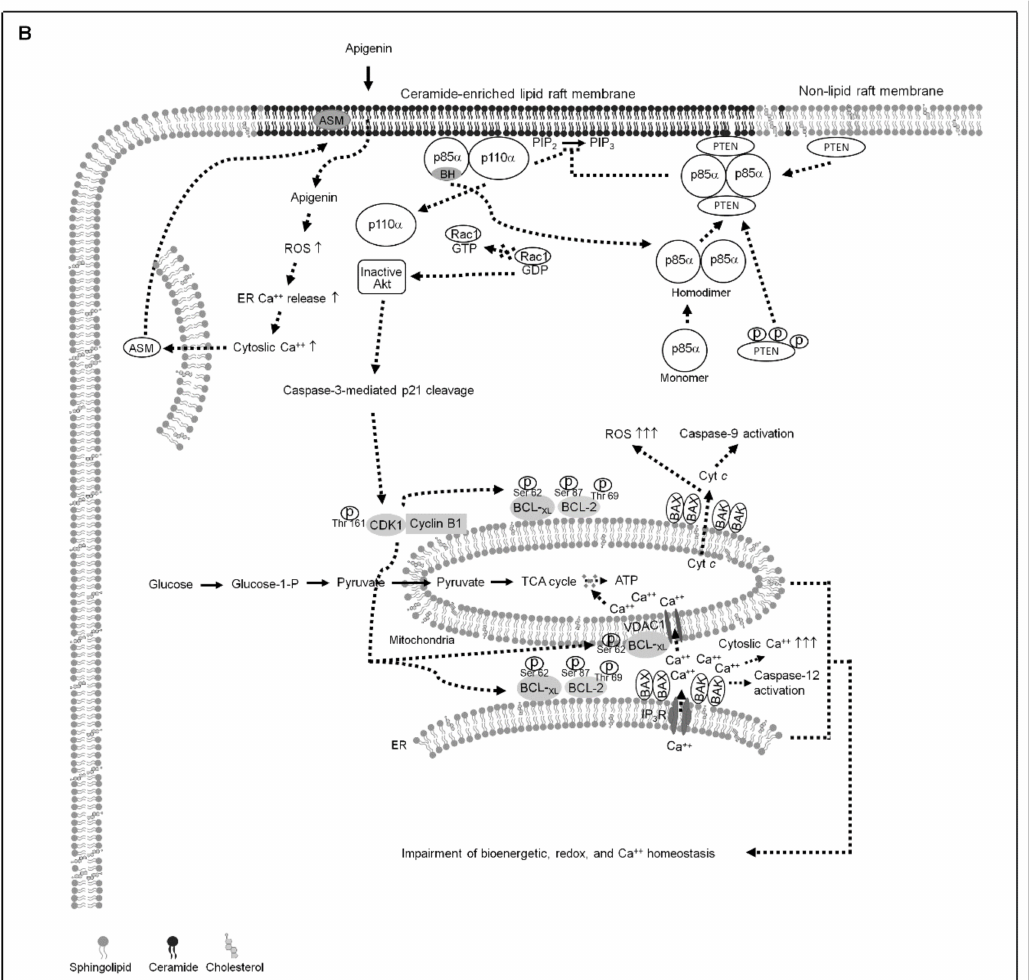
Figure 7. A molecular model for the attenuation of endoplasmic reticulum (ER) − mitochondria-mediated bioenergetic and lipid metabolic homeostasis by apigenin in nasopharyngeal carcinoma (NPC) cells. ( A ) The formation of clustered phosphatidylinositol 3-kinase (PI3K) − protein kinase B (Akt) − GTP-ras-related C3 botulinum toxin substrate 1 (Rac1) signaling platform in the lipid raft membranes constitutes a central element in the control of p21-mediated cyclin dependent kinase 1 (CDK1) − cyclin B1 inactivation to contribute initiation of B-cell lymphoma-extra large (BCL-x L )/ B cell lymphoma 2 (BCL-2)-inhibited Bcl-2-associated x protein (BAX)/Bcl-2 antagonist killer 1 (BAK) pro-apoptotic and metabolic activities, thereby modulates the ER − mitochondria-regulated bioenergetic, redox, and calcium (Ca ++ ) homeostasis. ( B ) Under the condition of cellular apigenin uptake, apigenin induces the lipid raft membrane translocalization of acid sphingomyelinase (ASM) from lysosome to promote the generation of ceramide-enriched lipid raft membranes by triggering oxidative stress-induced ER Ca ++ release, thus inducting the formation of p110 α -free homodimerized p85 α –unphosphorylated phosphatase and tensin homolog deleted from chromosome 10 (PTEN) tetrameric complexes and thereby disturbing the interaction between p85 α and p110 α in the lipid raft membranes. The resultant lipid raft membrane-associated p85 α –PTEN complexes can negatively regulate Akt activity and attenuate Rac1 activation by dephosphorylating the 3-position of phosphatidylinositol-3,4,5-trisphosphate (PIP 3 ) to phosphatidylinositol-4,5-bisphosphate (PIP 2 ). Akt inactivation was accompanied by induction of caspase-3-mediated p21 cleavage resulting the mitochondrial localization of p-CDK1 (Thr 161)–cyclin B1 complexes, which causes the phosphorylation of ER–mitochondria-associated BCL-x L (Ser 62)/BCL-2 (Thr 69/Ser 87) and then results in the dimerization/oligomerization of BAX/BAK, thereby attenuating the regulatory effects of BCL-x L /BCL-2 on the control of ER − mitochondria-regulated bioenergetic, redox, and Ca ++ homeostasis as well as